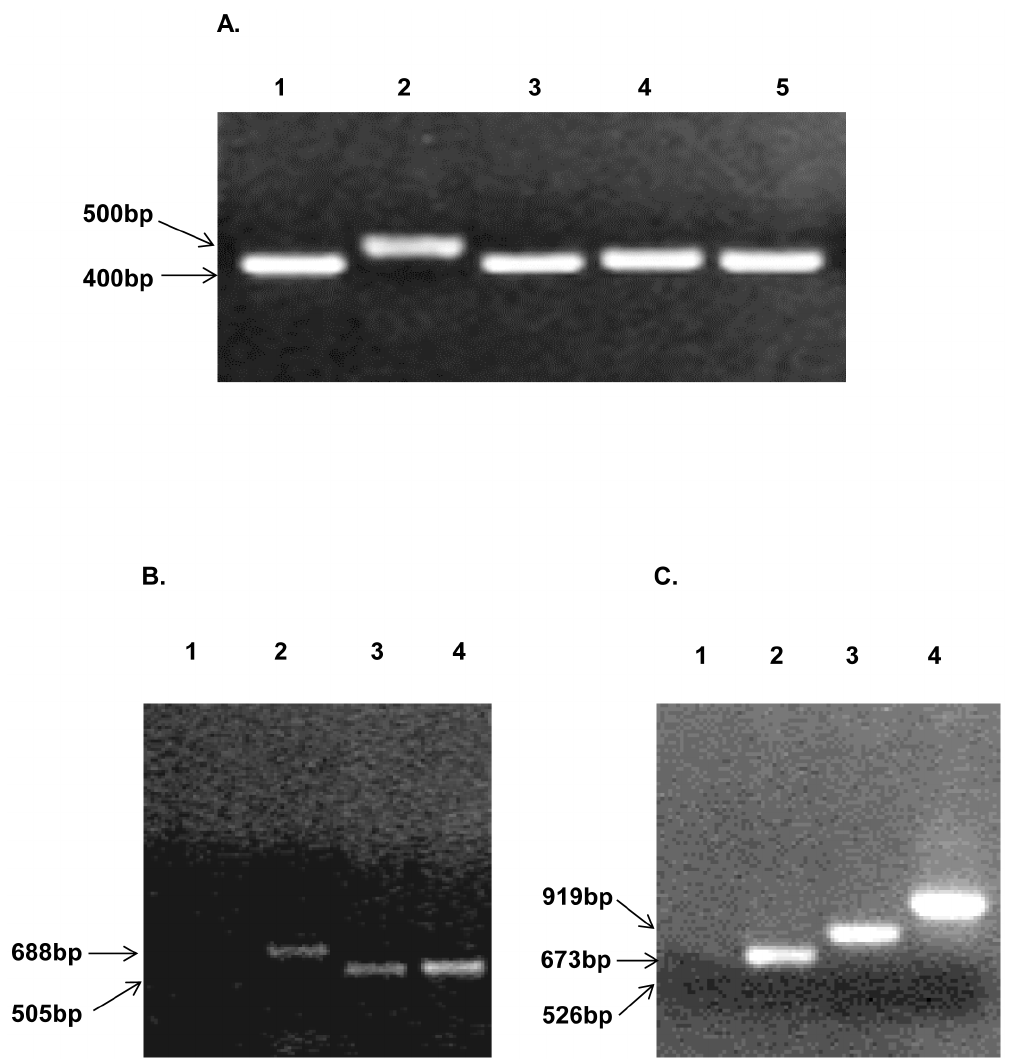
Figure 1. KWAS and His 6 genetically incorporated into the HVR1 location as well as His 6 within HVR2 or HVR5. Rescued vectors were amplified and viral DNA analyzed to confirm stable modification of relevant genes. A) Hexon-specific PCR primers confirmed the presence of the hexon gene in all of the modified vectors. Lane 1, Ad5; lane 2, Ad5/HVR2-MPER-L15 D E1; lane 3, Ad/H5-HVR1-His 6 ; lane 4, Ad5/H5-HVR1-KWAS-HVR2-